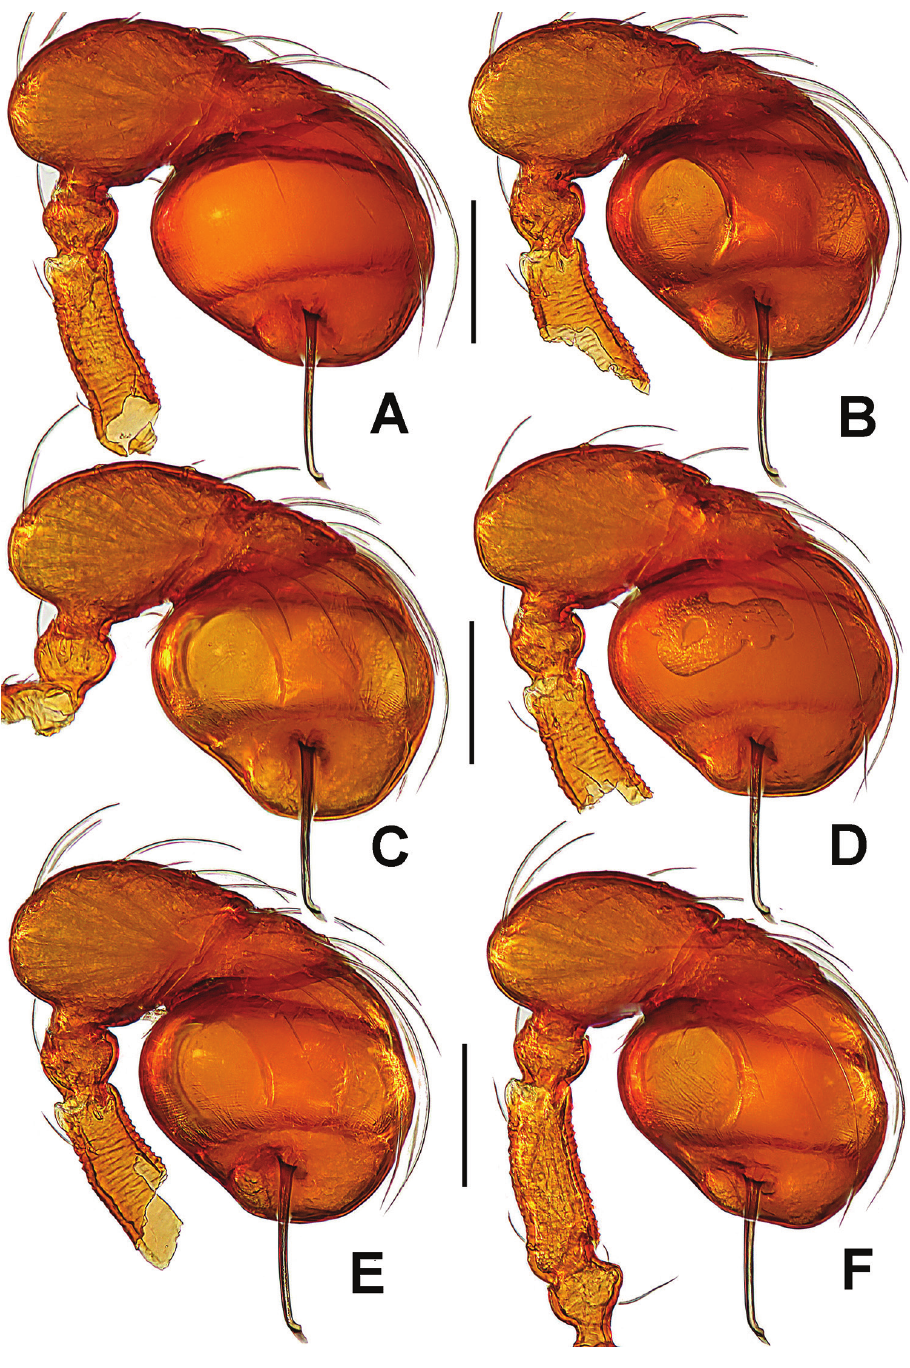
Figure 18. Singaporemma lenachanae sp. n., male paratypes. A–F left palps, prolateral. Scale bars: 0.10